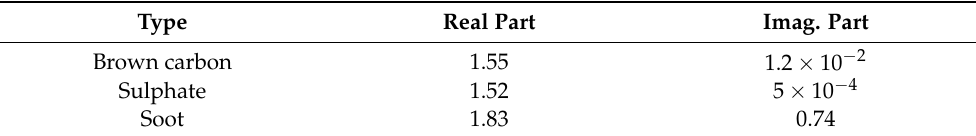
Table 1. Complex aerosol refractive index at 550 nm used in the plume